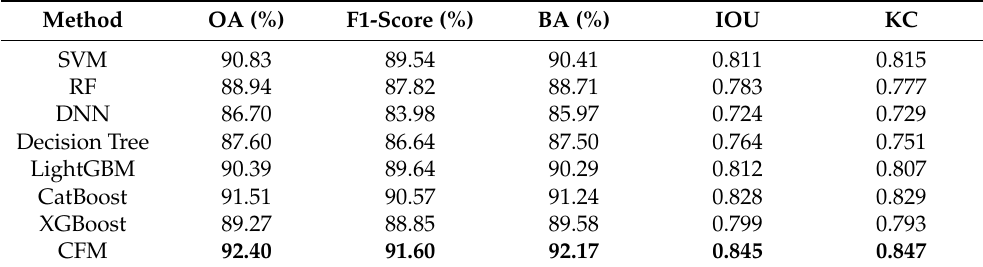
Table 5. Evaluation of the performance of different FSM models over the Goranrud basin. Support Vector Machine (SVM), Random Forest (RF), Deep Neural Network (DNN), Decision Tree (DT), Light Gradient Boosting Machine (LightGBM), Categorical Boosting (CatBoost), Extreme Gradient Boosting (XGBoost), and Cascade Forest Model (CFM). OA: overall accuracy; IOU: intersection over union, BA: balance accuracy; KC: kappa coefficient. The highest value is in bold.